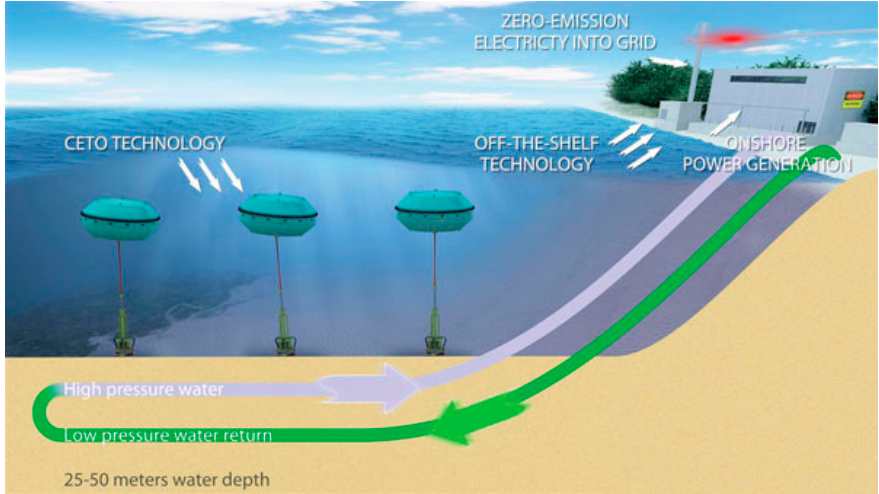
Figure 3. CETO technology and the desalination pilot plant (DPP), obtained from Viola [16], with permission licensed under CC BY-NC 4.0 from International Journal of Heat and Technology, 2016.